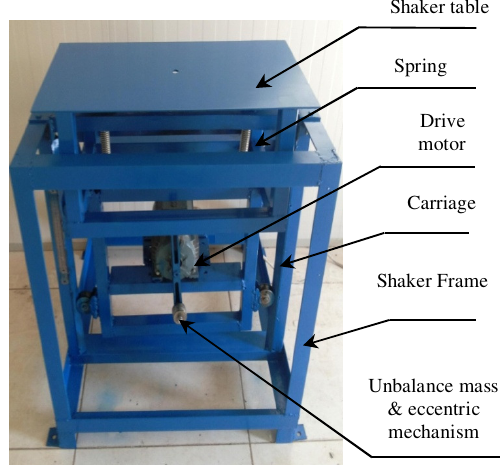
Fig. 3. Variation of amplitude ratio and phase angle versus frequency ratio for different values of ζζζζ . [5]